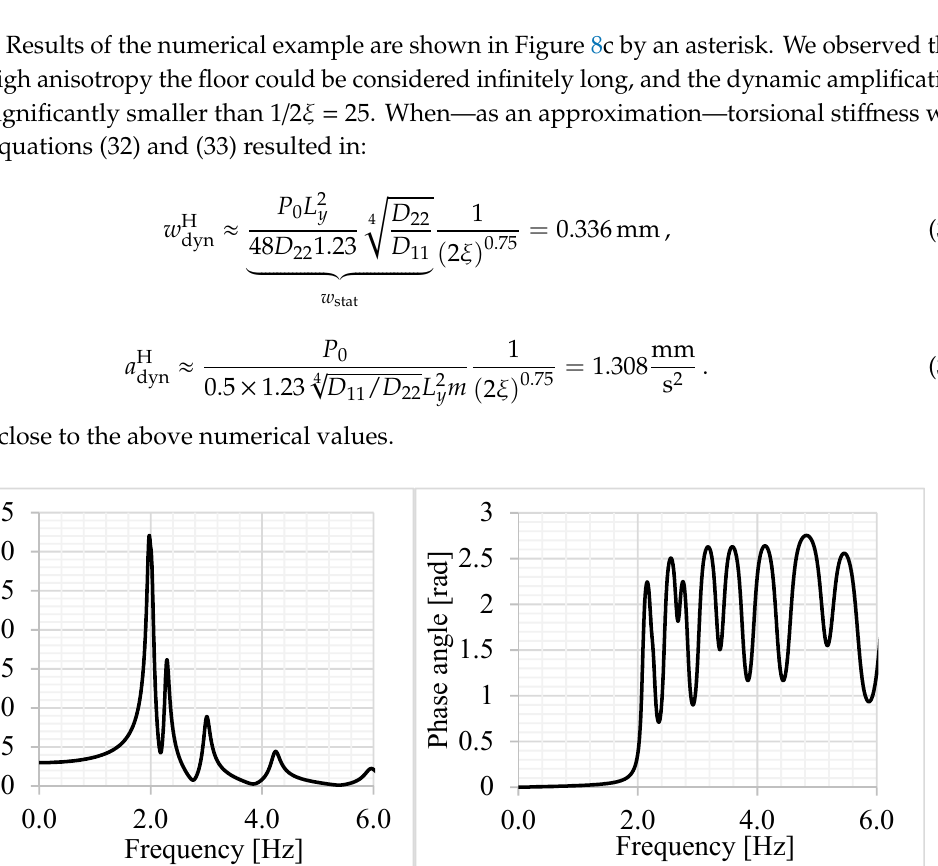
Figure 12. Geometry of the analyzed floor.